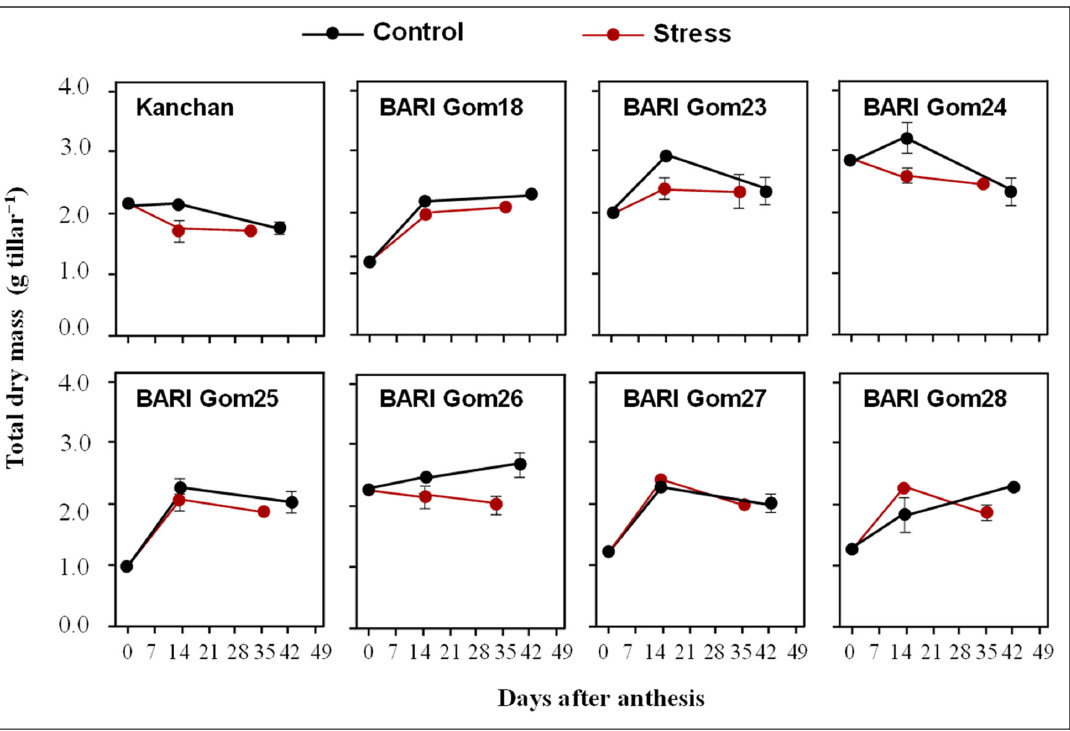
Figure 4. Changes in total dry mass (g tiller − 1 ) of eight wheat cultivars as affected by drought stress during the grain-filling period. Vertical bars represent standard errors of means ( n = 3). Table 2. Phenological characters, grain filling rate, and individual grain weight in eight wheat cultivars as affected by drought stress during the grain filling